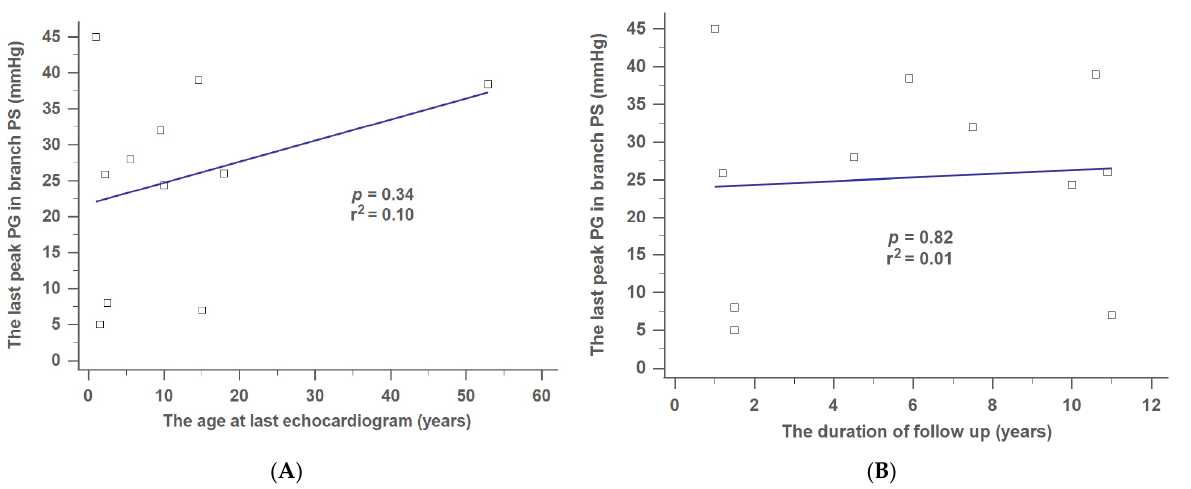
age at last echocardiogram (Figure 5A) or the duration of follow-up (Figure 5B). Never- 0.82, the duration of follow-up).